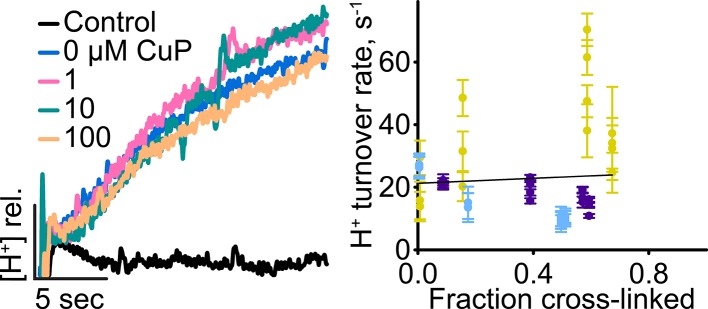
H+ turnover of D417C/Y445S.Left: Representative data traces showing H+-transport activity. Right: Summary data showing H+-transport activity as a function of disulfide cross-linking. Each data point represents one flux-assay measurement, with error bars indicating the uncertainty in curve-fitting to the primary data. Data are from three separate preparations, with data from each preparation shown in a different color.